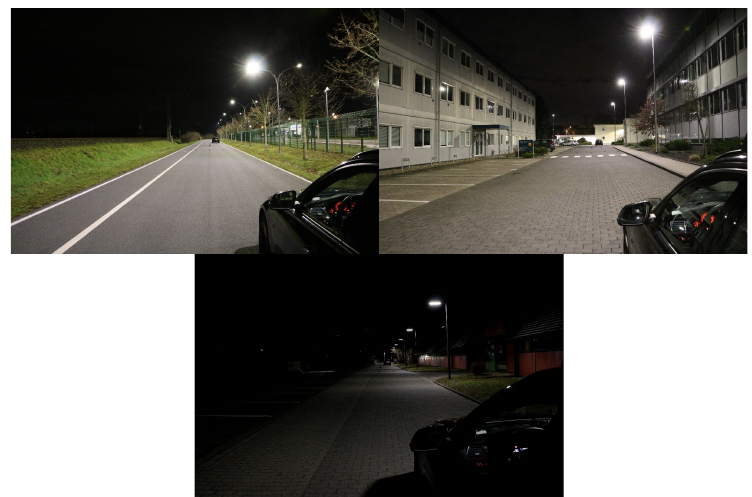
Figure 1. Test roads on which the study was conducted: ( top left ) test road 1 (M4 class); ( top right ) test road 2 (M5 class); ( bottom ) test Road 3 (M6 class).